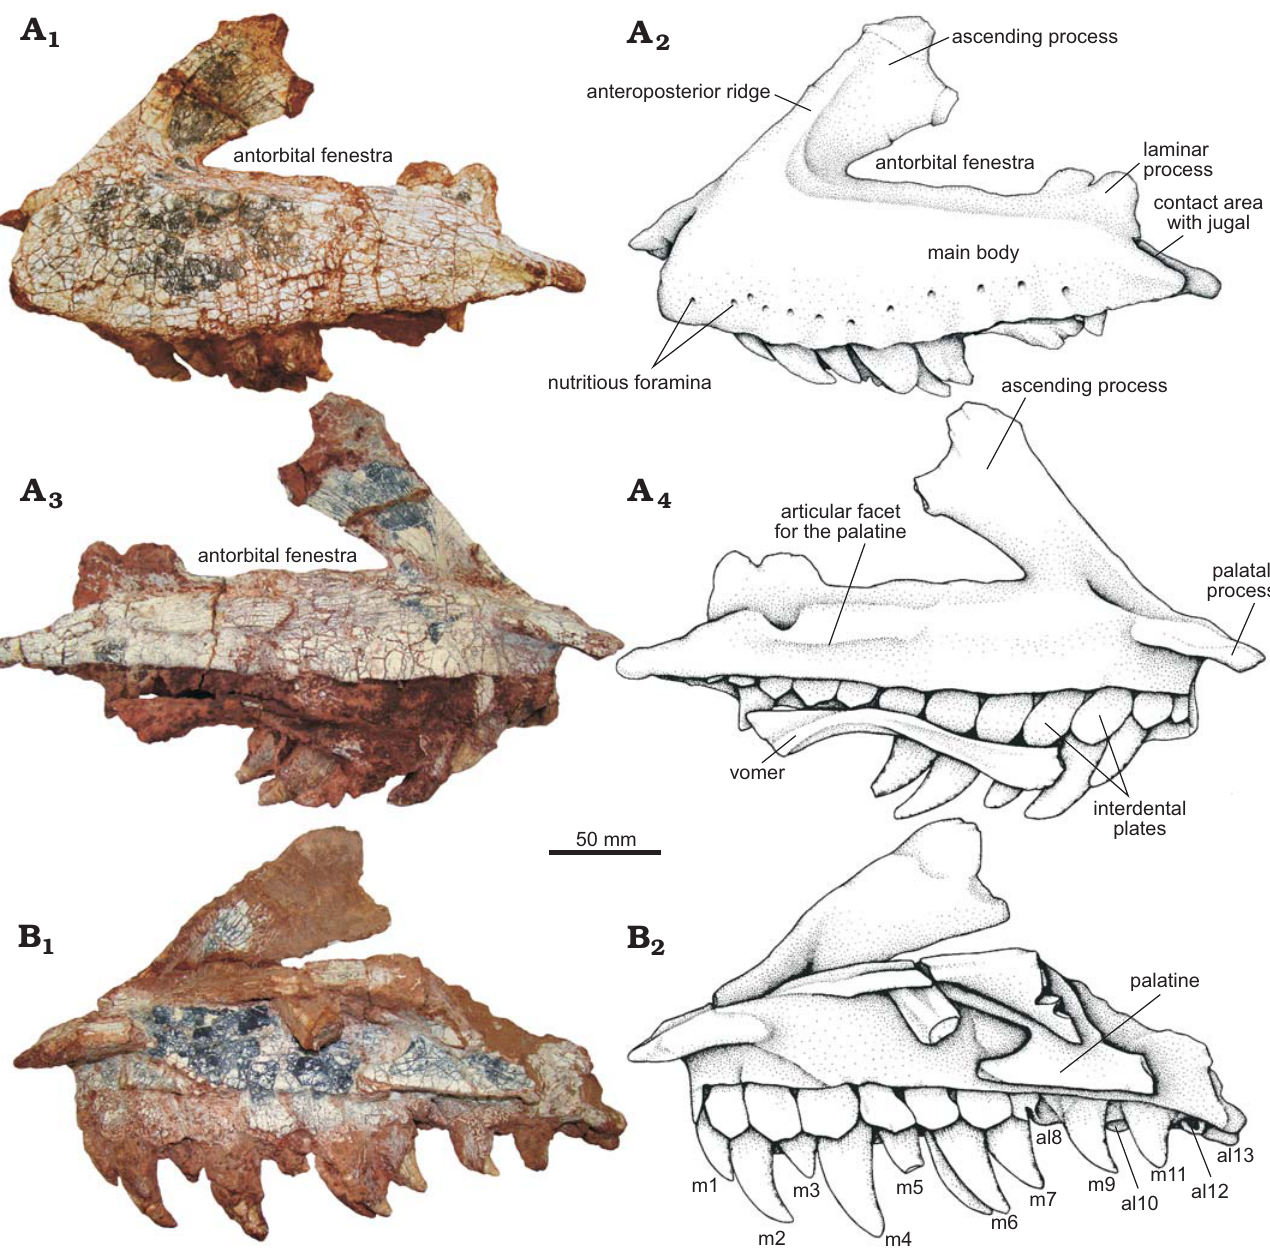
Fig. 5. The pseudosuchian archosaur Prestosuchus chiniquensis Huene, 1938 (UFRGS-PV-0629-T) from the Dinodontosaurus Assemblage Zone, Ladinian, Middle Triassic, Dona Francisca municipality, Rio Grande do Sul State, Brazil. A . Left maxilla in lateral (A 1 , A 2 ) and medial (A 3 , A 4 ) views. B . Right maxilla in medial view. m1–7, m9, m11, refer to maxillary tooth position; al10, al12, al13, refer to maxillary alveolus position. Photographs (A 1 , A 3 , B 1 ) and explanatory drawings (A 2 , A 4 , B 2